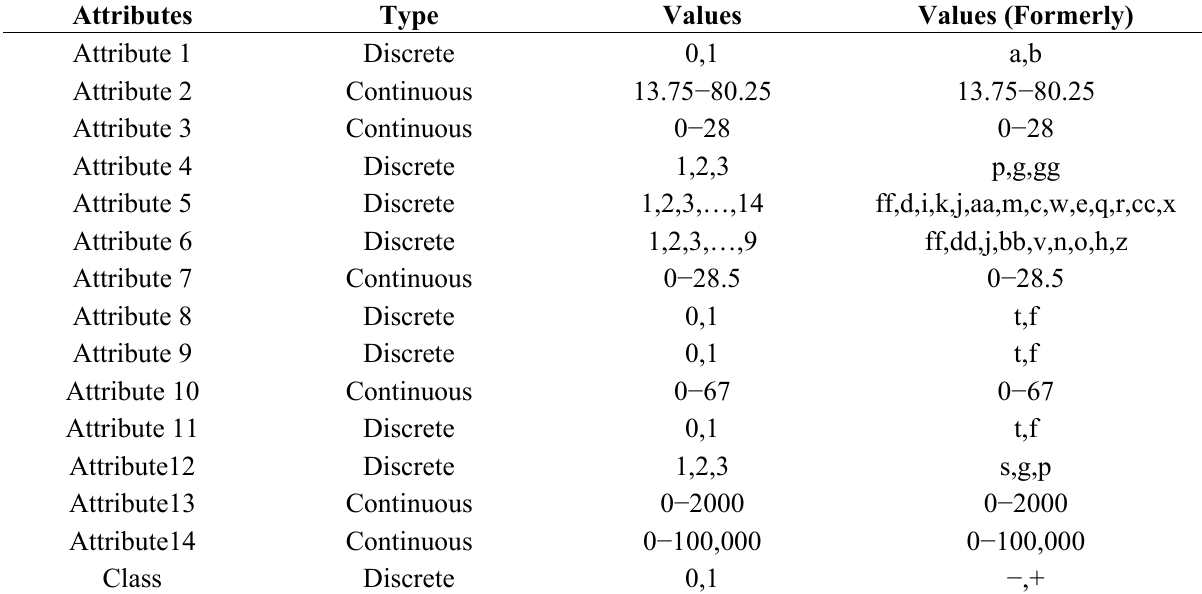
Table 1. Australian credit data